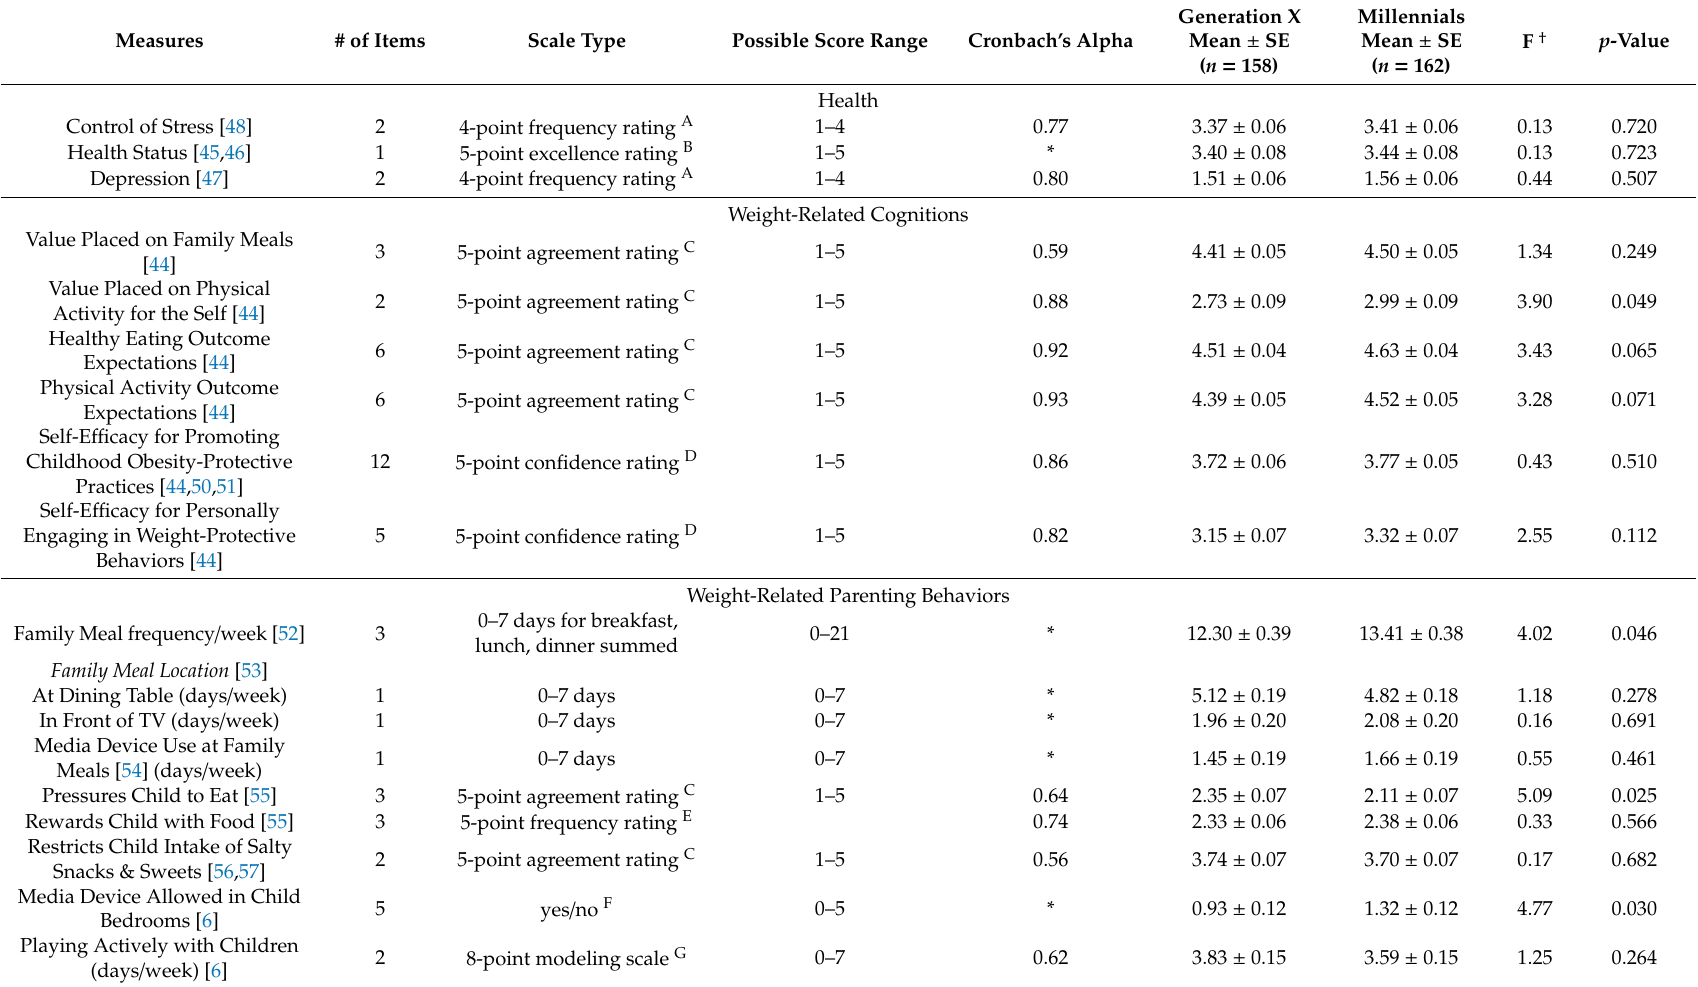
Table 1. Comparison of weight-related cognitions and behaviors between Generation X (born 1965 to 1981) and Millennial (born 1982 to 1999) mothers ( n = 320).